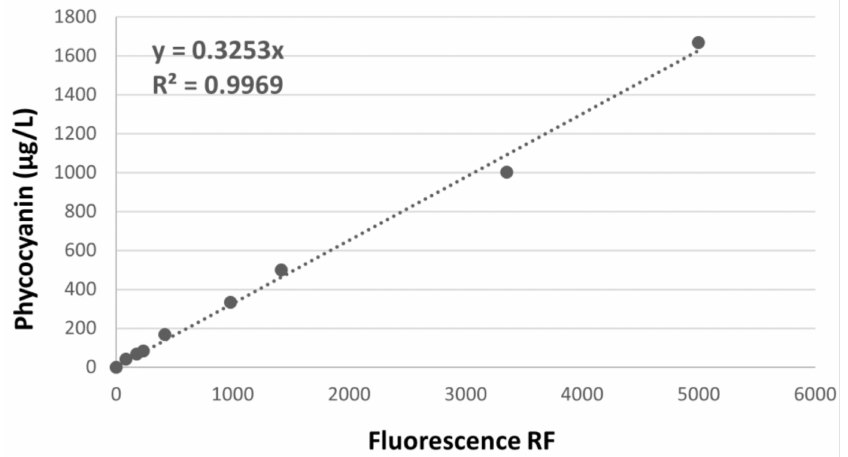
Figure 2. Calibration adjustment between raw fluorescence units (RF) and standard phycocyanin concentration for Hitachi FL-7000